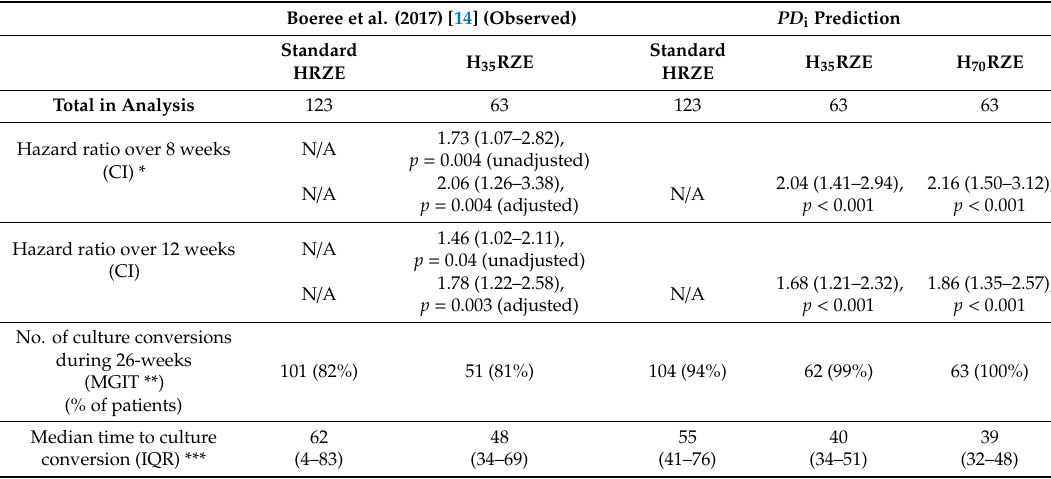
Table 1. Comparison between observed clinical outcomes (based on MGIT culture conversion results) in Boeree et al. (HRZE vs. RIF 35 HZE) and mathematically simulated outcomes using PD i modelling. The last column displays the results for a simulation of a hypothetical 70 mg / kg RIF dose-containing regimen (RIF 70 HZE) using PD i modelling. Hazard ratios are comparisons to the control treatment within the observation or simulation